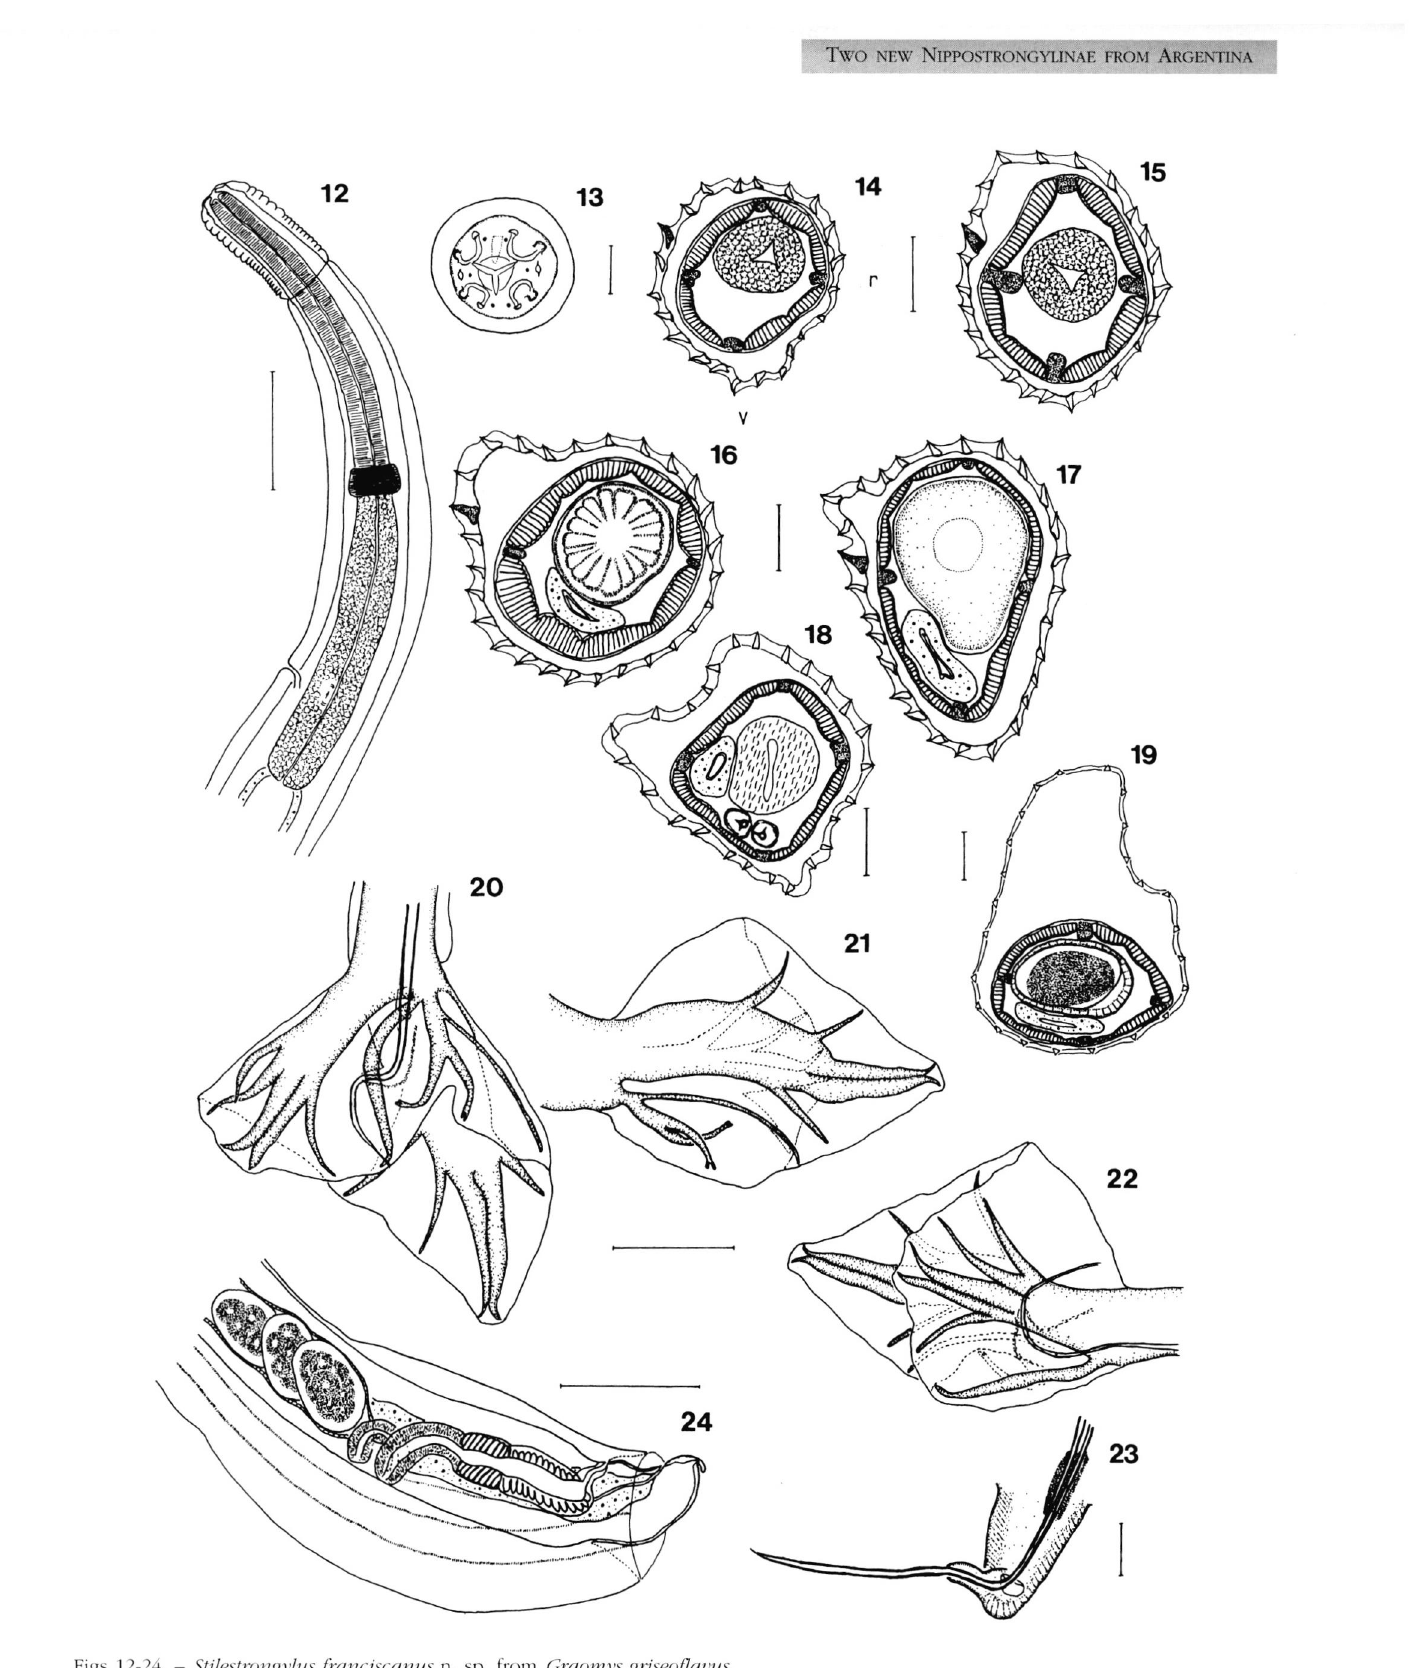
Parasite. 2003, 10,